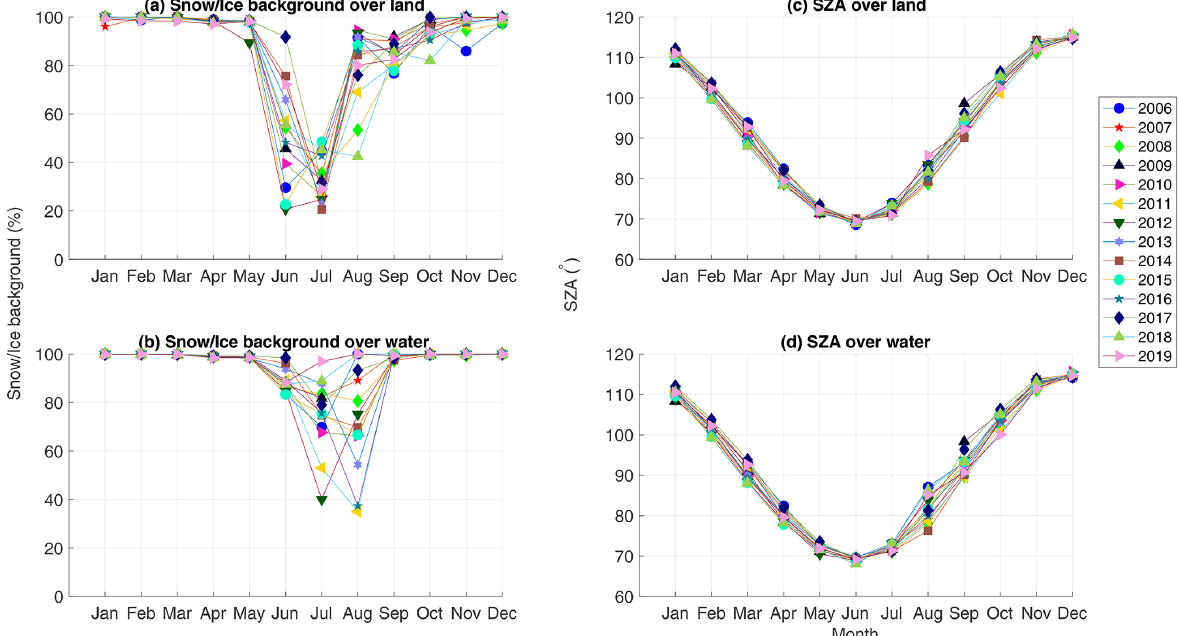
Figure 3. Monthly MODIS snow/ice background percentage over land (a) and water (b) and monthly solar zenith angle over (c) land and (d) water corresponding to MOPITT measurements shown in Fig.